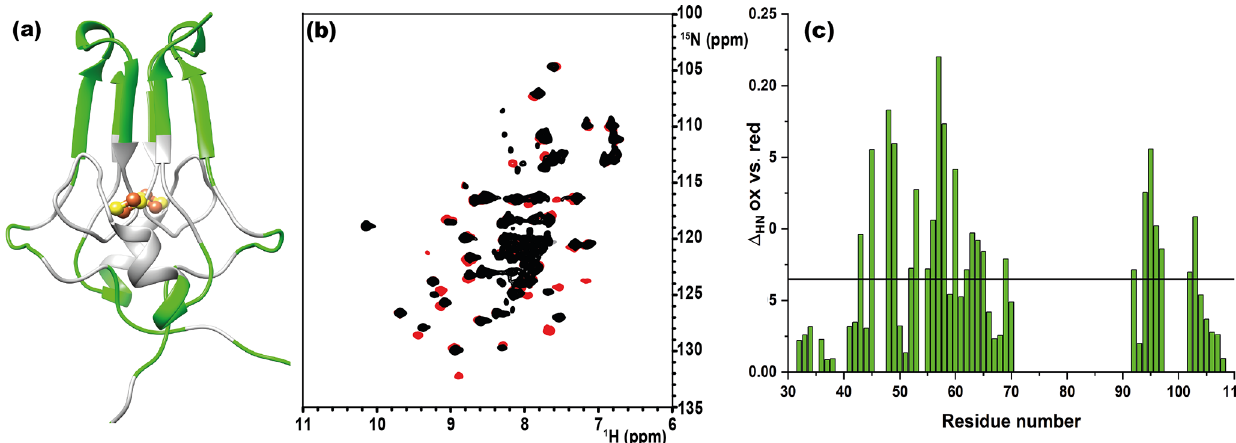
Figure 1. (a) Crystal structure of mitoNEET (2QD0). Protein segments in green could be identified in HSQC experiments and sequentially assigned in triple-resonance experiments for both oxidation states. (b) 1 H– 15 N HSQC overlap of mitoNEET oxidized (red) and reduced (black) at 700MHz at 298K. (c) Chemical shift differences between the two oxidation states of the protein. The black bar is the average plus 1 standard deviation, with the residues above it being those significantly different. The residue number follows the PDB X-ray crystal structure 2QD0 (Lin et al., 2007).